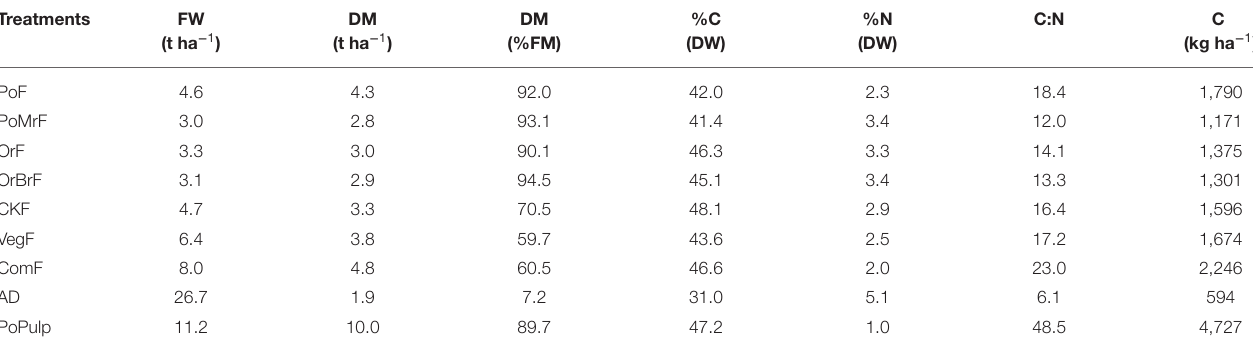
TABLE 2 | Fertilizer application rates for the pot experiment as expressed in fresh weight (FW) and dry matter (DM), percentage of nitrogen and carbon content of fertilizers based on dry matter (%N and %C), and the rate of applied C (kg C ha − 1 ) corresponding to 150kg N ha − 1 in each treatment.